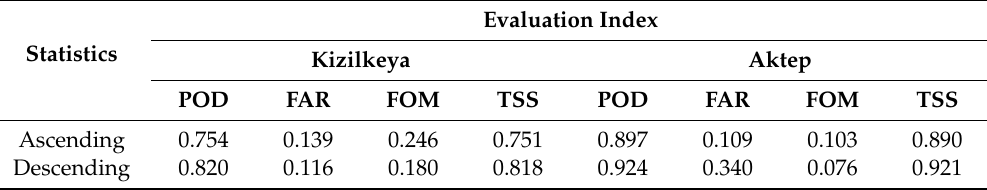
Table 7. Statistics for model evaluation.